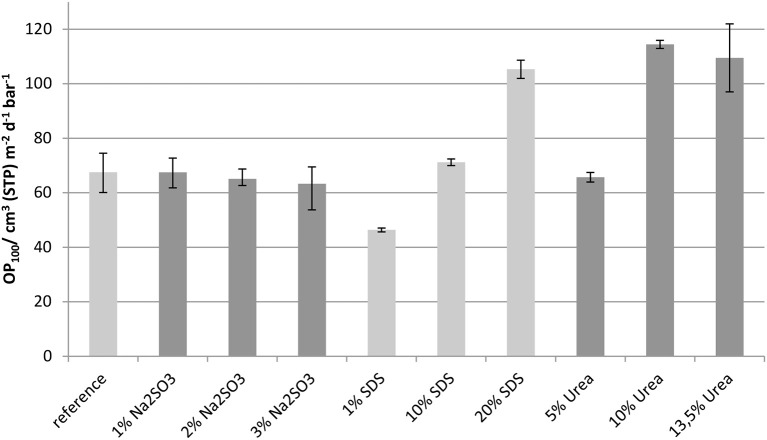
Oxygen permeability (OP100) measured at 23°C and 50% r.h.